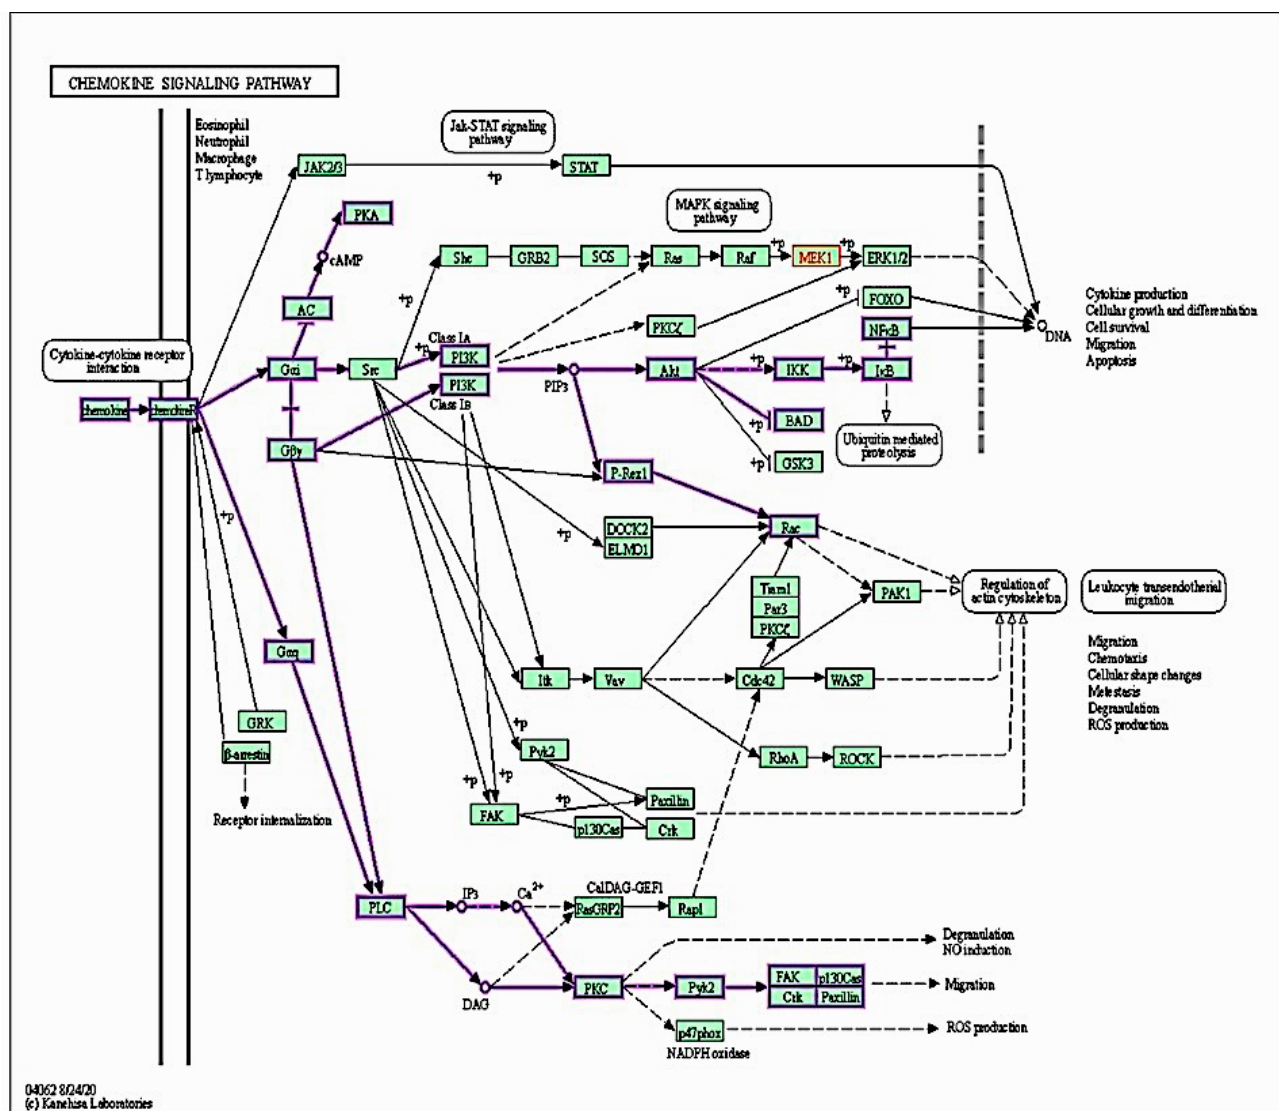
Figure 8. Chemokine signaling pathway. A graph generated by KEGG bioinformatic